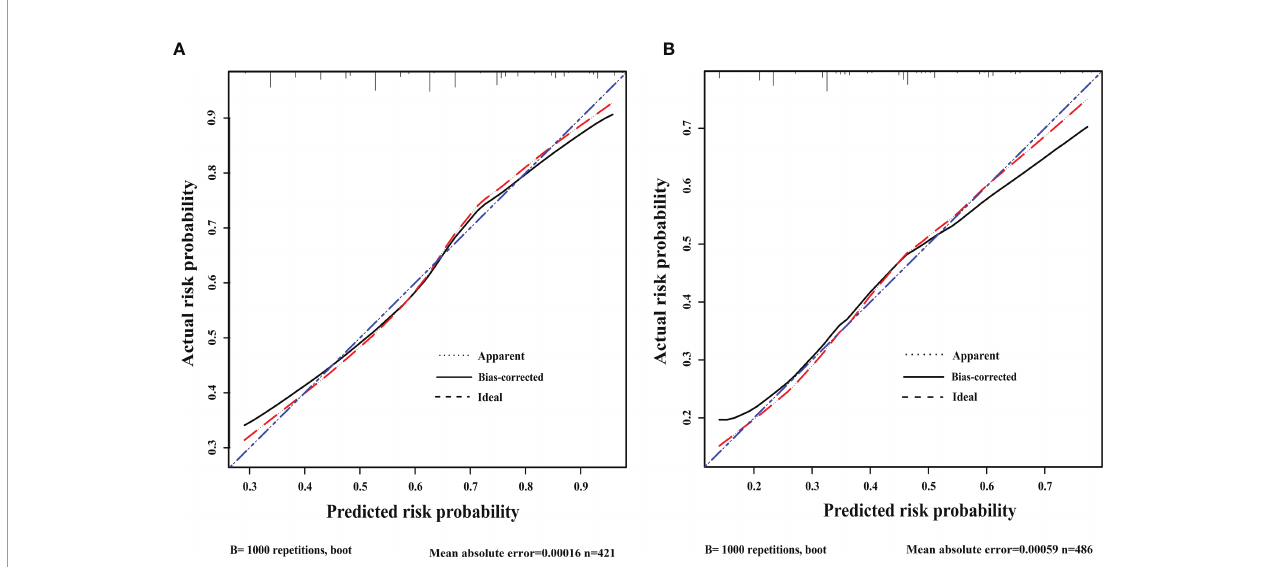
FIGURE 4 | (A) Discrimination plot. The nomogram predictive model showed that in patients <45 years old, the average absolute error of the actual risk probability and the predicted risk probability of this model was 0.00016. (B) Discrimination plot. The nomogram predictive model showed that in ≥ 45 years, the average absolute error of the actual risk probability and the predicted risk probability of this model was